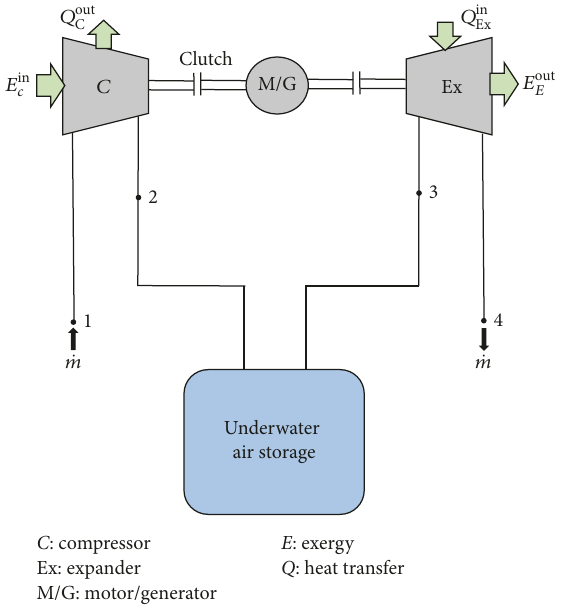
Figure 3: Schematic of isothermal